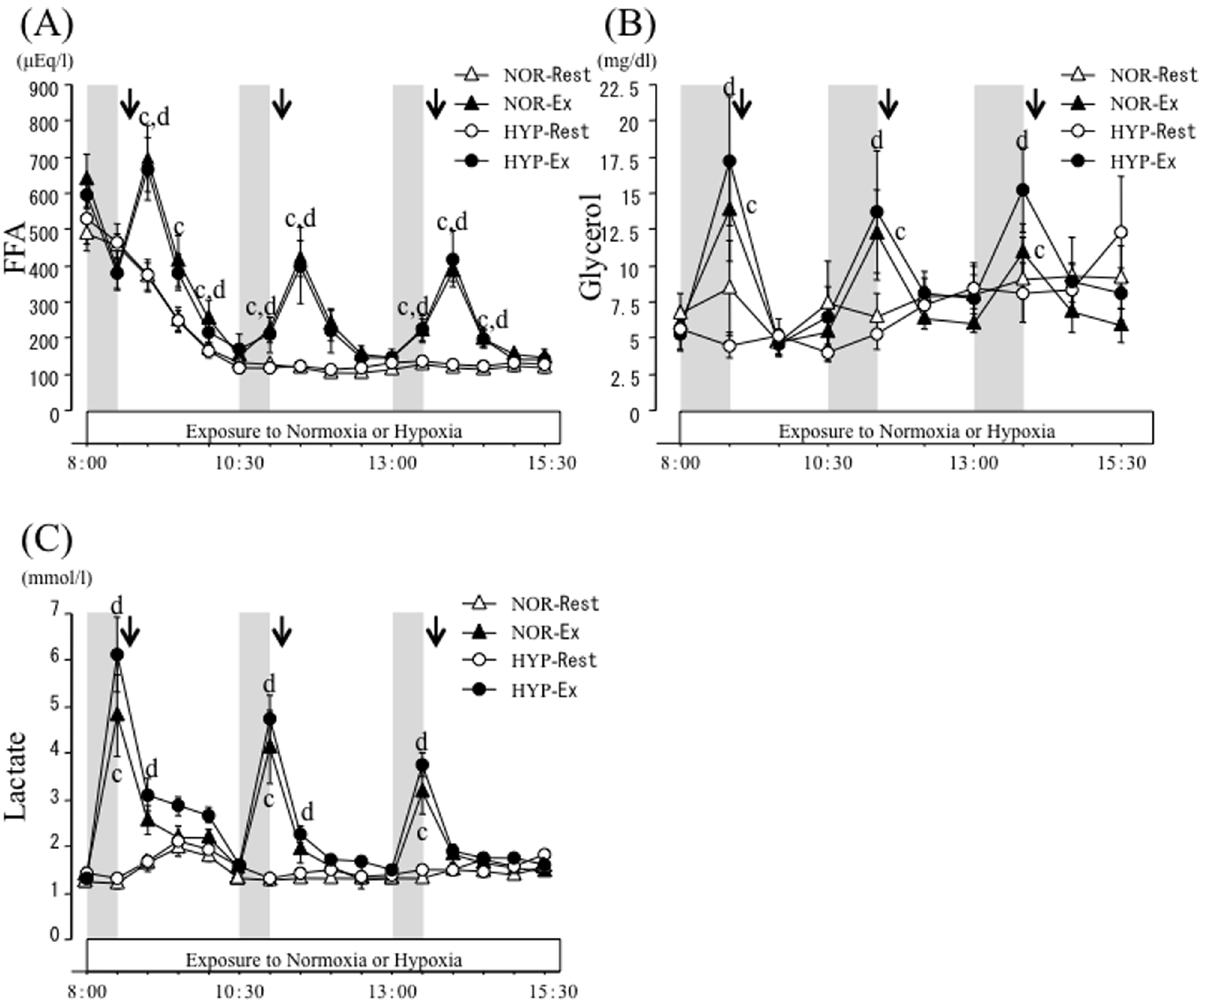
Figure 4. Time-course changes of FFA (A), glycerol (B) and lactate (C) concentrations over 7.5 h. Each period of exercise is indicated by the shaded boxes. The arrow indicates the time of meal consumption. c; P , 0.05, NOR-Rest vs. NOR-Ex. d; P , 0.05, HYP-Rest vs. HYP-Ex.